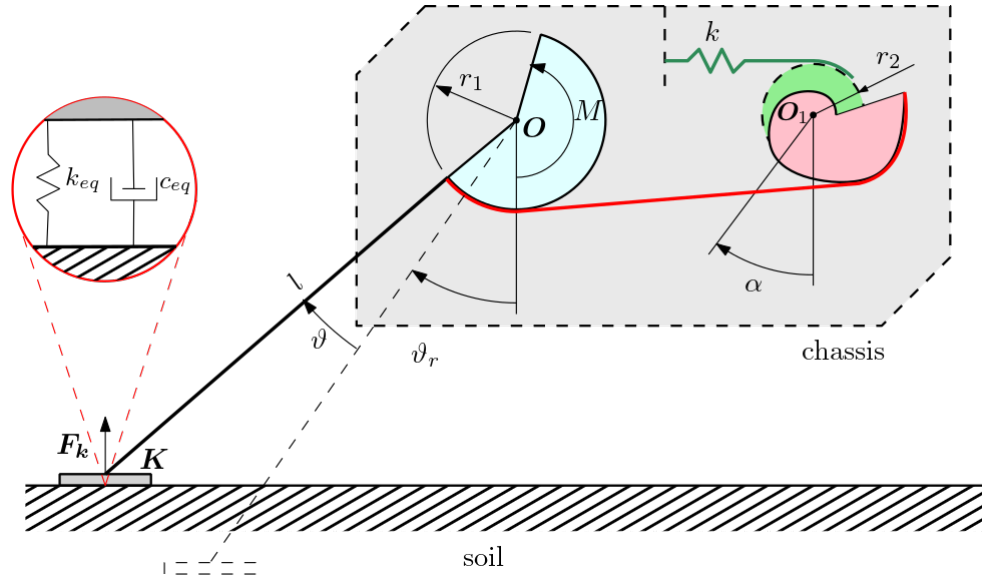
Figure 2. Schematic view of the lander-leg mechanism at the beginning of the impact with soil with detailed view of the model of the normal contact force as a spring–damper